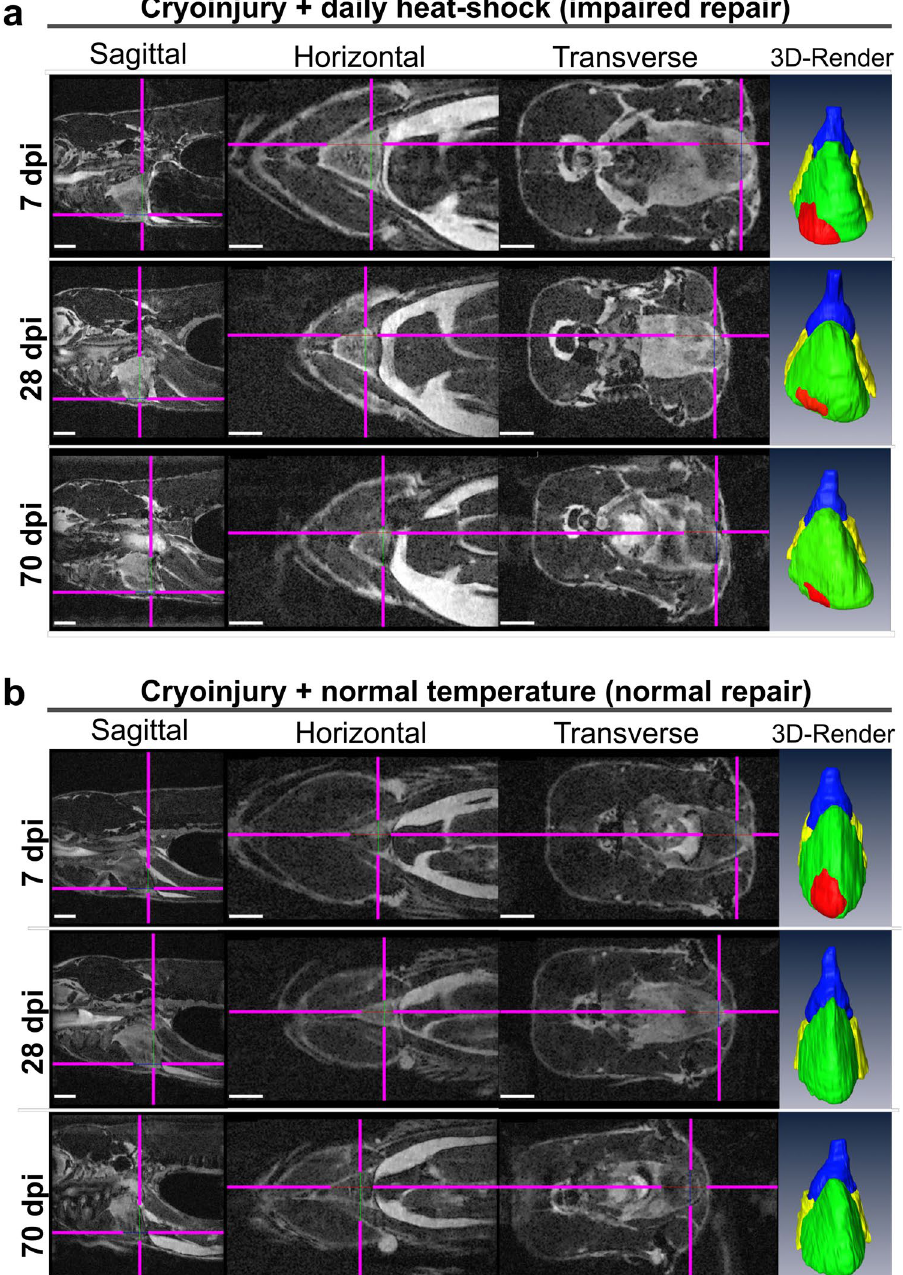
Figure 4. Impaired heart regeneration in a live specimen can be followed for at least 70 days. Orthogonal views of MR images of the two cryo-injured live Tg ( hsp70l:dnfgfr1a-EGFP ) + / − fish with (a) and without (b) daily heat-shock (HS) treatment at 7, 28, and 70 days post injury. Shown is the precise location of the lesion in each fish in 3 optical planes (sagittal, horizontal and transverse) and as a ventral view 3D Amira reconstruction (3D Render) of the heart (red-lesion, green-ventricle, blue-bulbus arteriosus, yellow-atrium). The injury location is indicated in each plane by pink crosshair lines, in order not to obscure the heart, the cross-hairs are drawn thinner above the heart and injury site. n = 4 per group. Scale bar 1